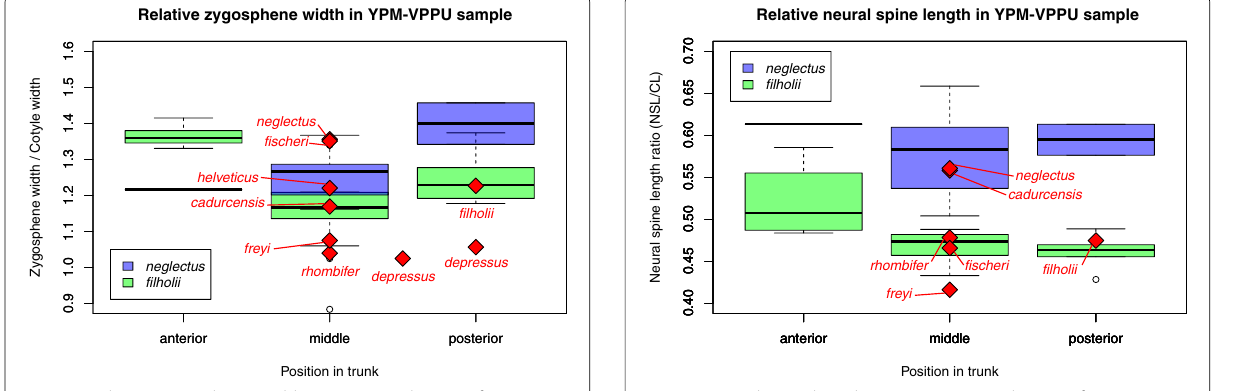
Fig. 46 Relative zygosphene width in YPM populations of “ Palaeopython ” neglectus and Phosphoroboa filholii comb. nov. compared to same ratio in type material of various Paleogene constrictors from Europe. There is very little overlap between the two populations haemal keel is sharp and seems to extend over most of the midline of the centrum. The sharpness of the haemal keel and the vaulting of the neural arch denote that these vertebrae originate from around the mid-trunk region.